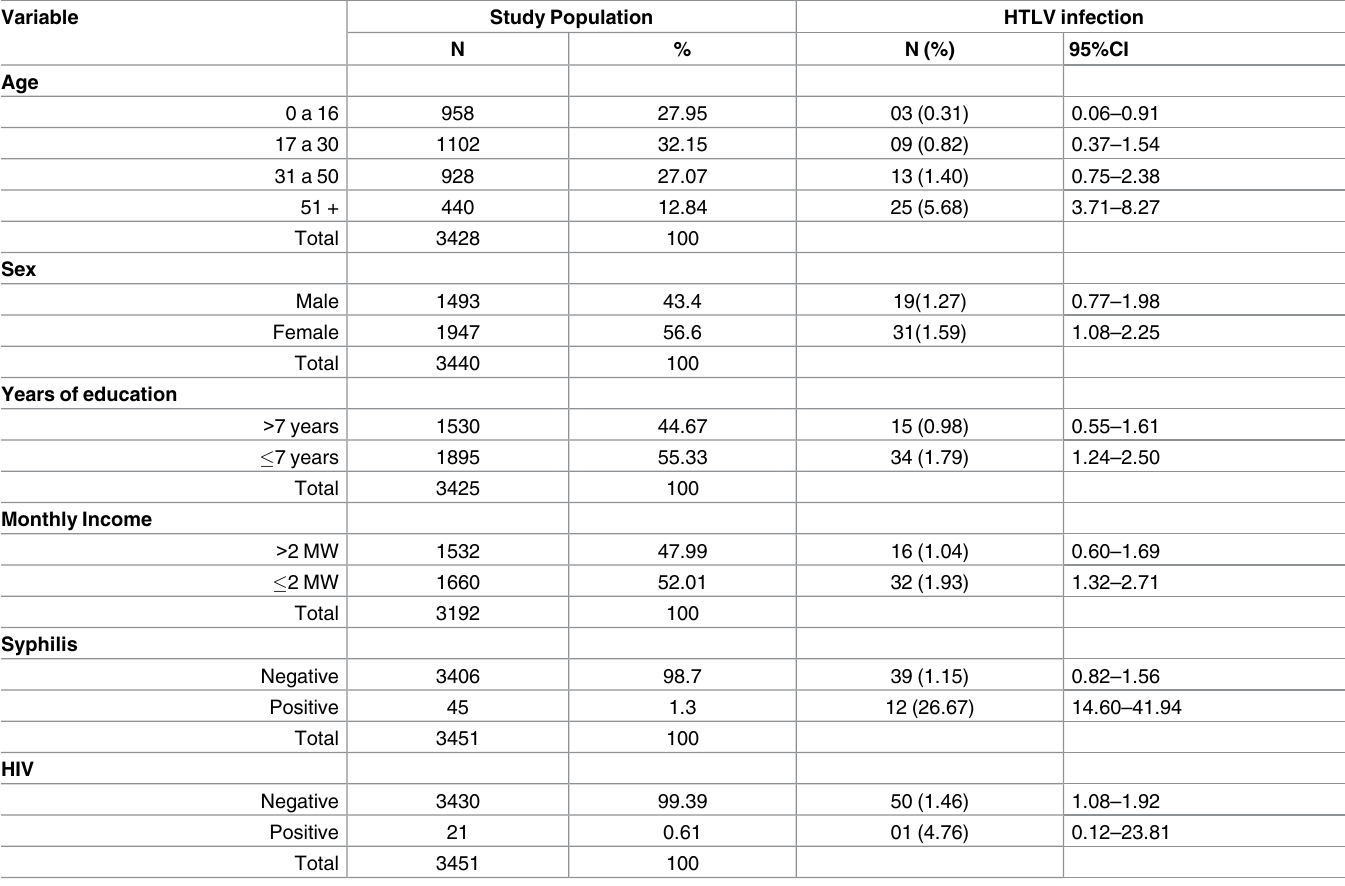
Table 1. Study population and Prevalence Rate of HTLV-1 Infection according to study variables. Salvador, Northeast Brazil. Variable Study